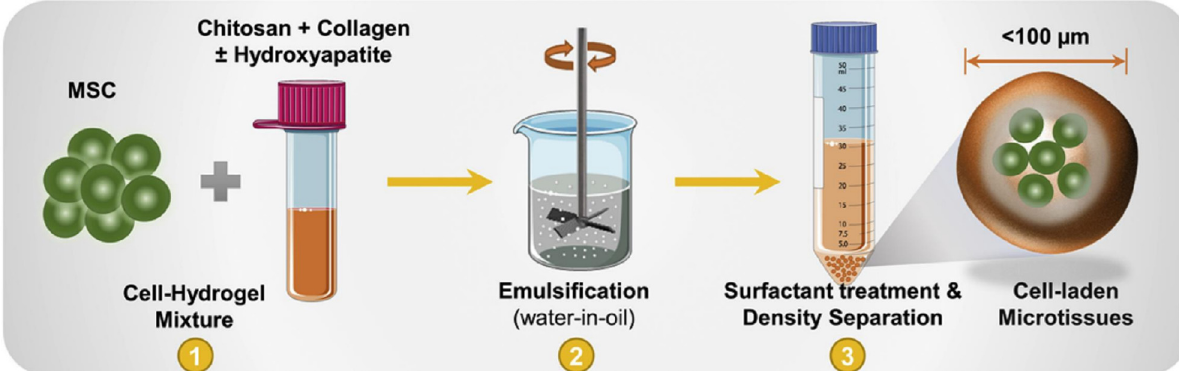
Figure 4. Fabrication of mesenchymal stromal cells (MSC) cell-laden chitosan-collagen microgels. Emulsification was used to generate the microgels with a particle diameter of about 100 µm. The microgels were able to maintain cell viability for up to 21 days. The figure has been reproduced with permission from Elsevier [74].